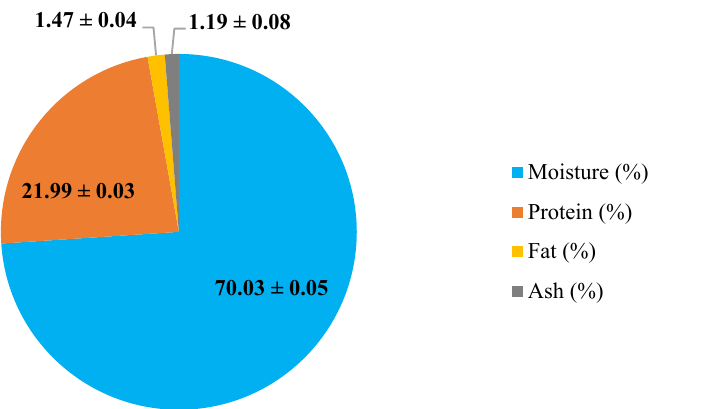
Figure 1. Proximate composition of chicken breast fillets. Results are expressed as average ± standard